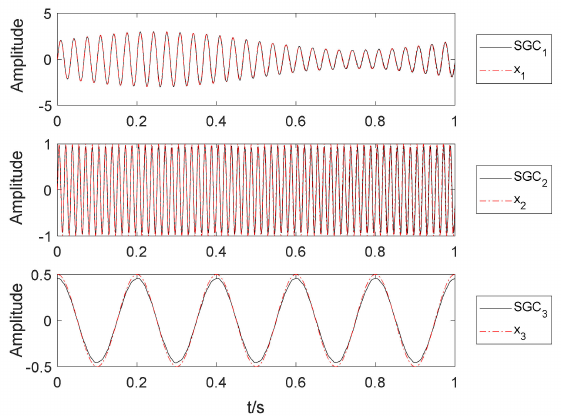
Figure 8. Time domain waveforms of real components and SGMD-CS decomposition